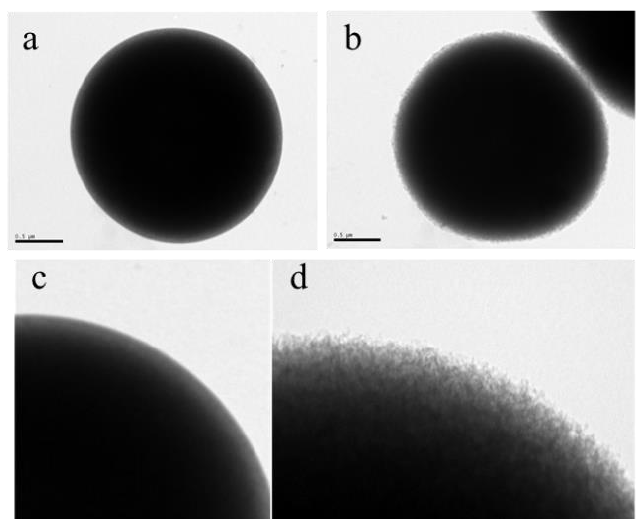
Figure 2. TEM images of ( a , c ) bare SiO 2 , and ( b , d ) SiO 2 @P2VP- b -PEO particle hybrid. Scale bars in ( a , b ) 500 nm. The ( c , d ) images are magnifications of the corresponding ( a , b ) images, respectively. Polymers 2020 , 12 , x FOR PEER REVIEW